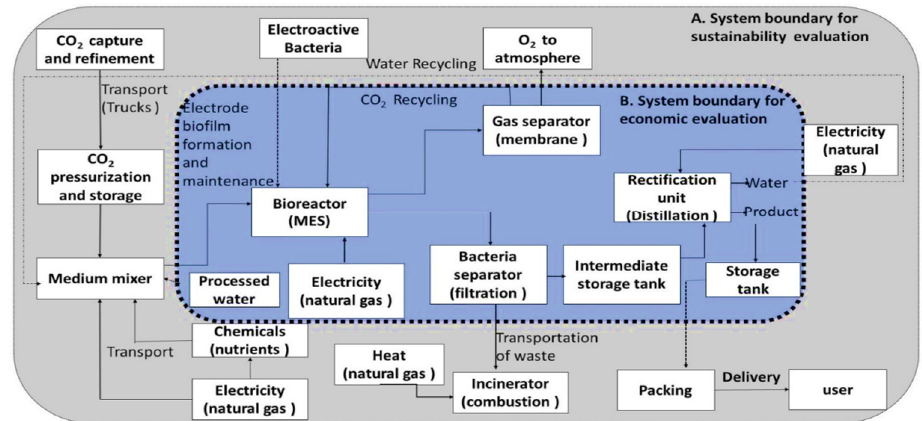
Figure 6. Schematic representation of sustainability and techno-economic assessment of MES.